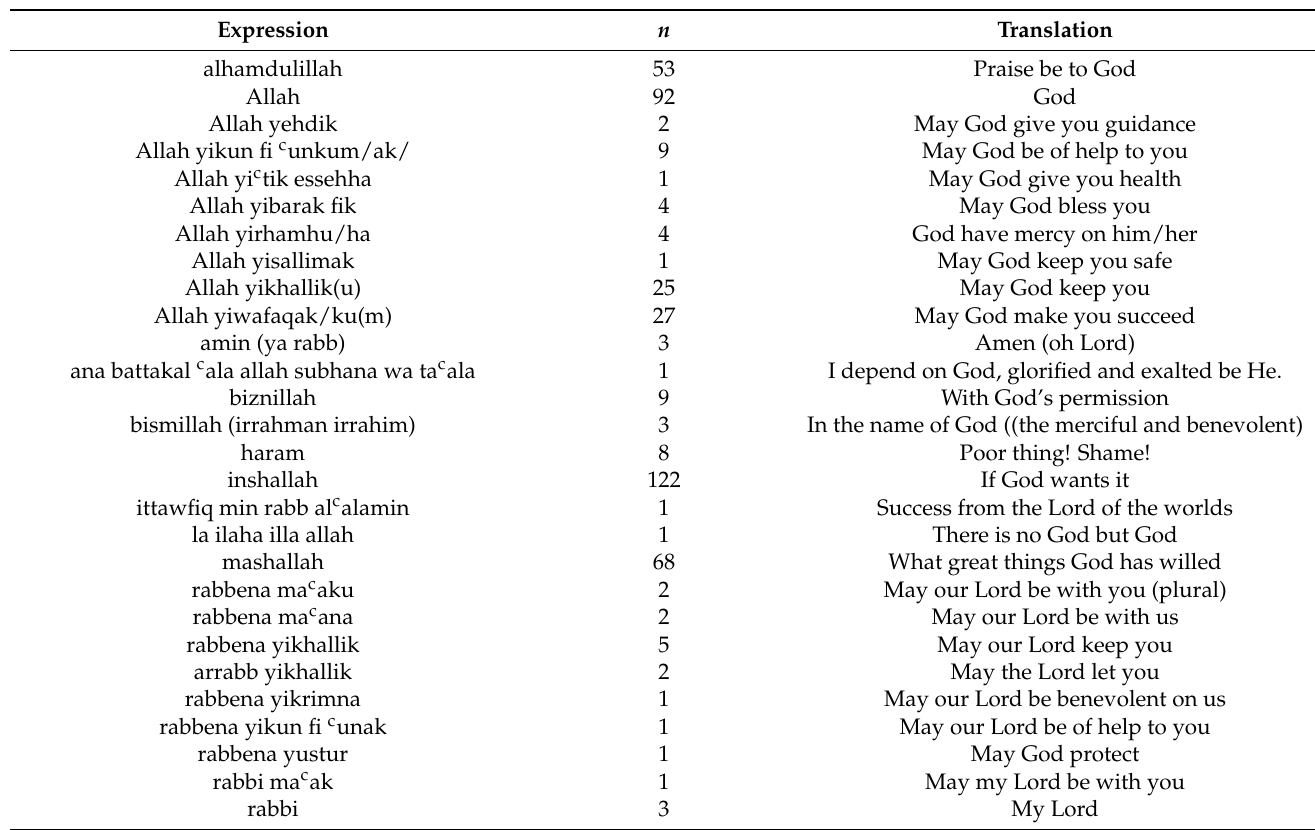
Table 2. References in The Arab Voice